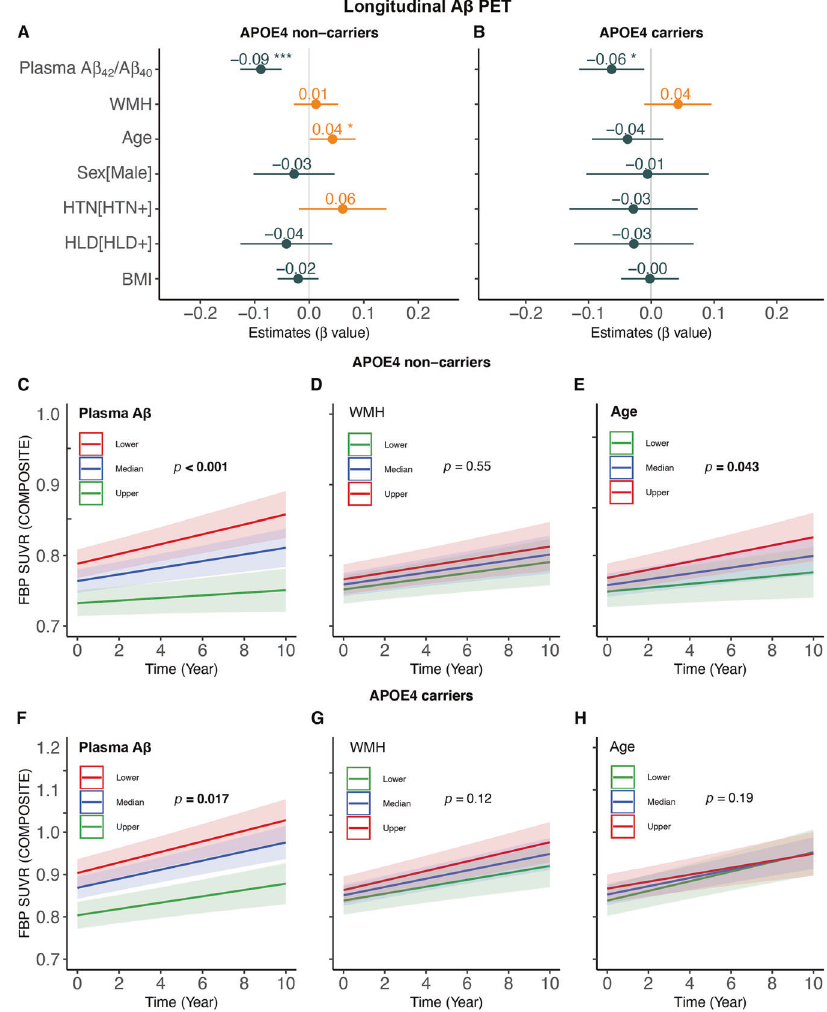
Fig. 2 Predictors of longitudinal A β PET changes. The estimated β values of each predictor for longitudinal A β PET changes in linear mixed effect models in ( A ) APOE- ε 4 non-carriers and ( B ) APOE- ε 4 carriers. Prediction of longitudinal A β PET changes over time by baseline plasma A β 42 /A β 40 , WMH and age in APOE- ε 4 non-carriers ( C – E ) and APOE- ε 4 carriers ( F – H ). Note: lower, median and upper represent the value that cuts off the fi rst 25%, 50% and 75% of the data when it is sorted in ascending